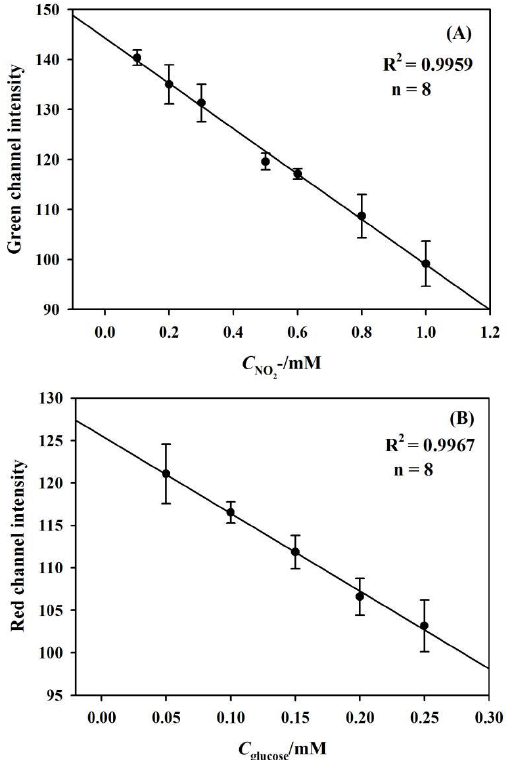
Figure 9. ( A ) The calibration plot of Green channel intensity and nitrite from 0.1 mM to 1.0 mM. ( B ) The calibration plot of Red channel intensity and glucose from 0.05 mM to 0.25 mM.